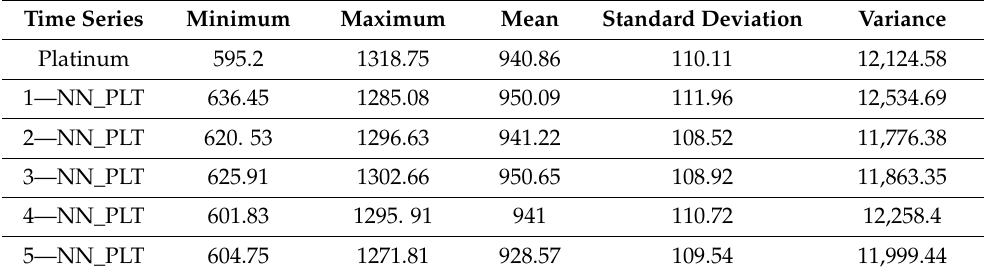
Table 2. Statistical characteristics of smoothed time series and platinum prices.